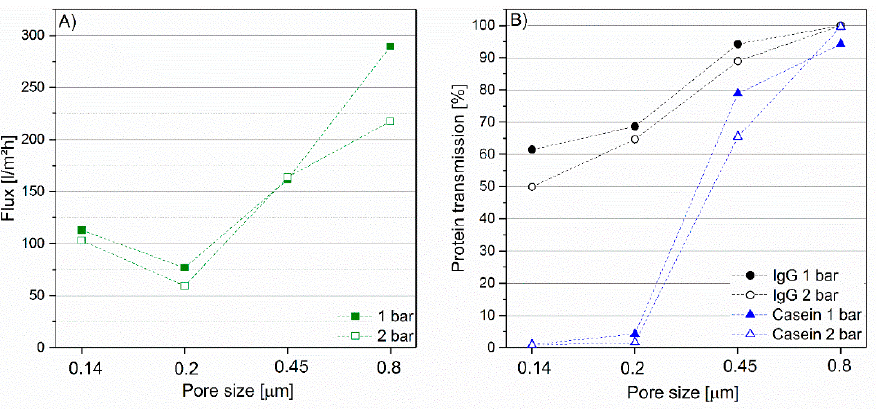
Figure 4. Flux ( A ) and IgG plus casein transmission ( B ) as a function of pore size at 1 bar (filled symbols) and 2 bar (open symbols) (gradient membrane, 50 °C). For equivalent of β -Lg and time dependent data, see Supplementary Information.